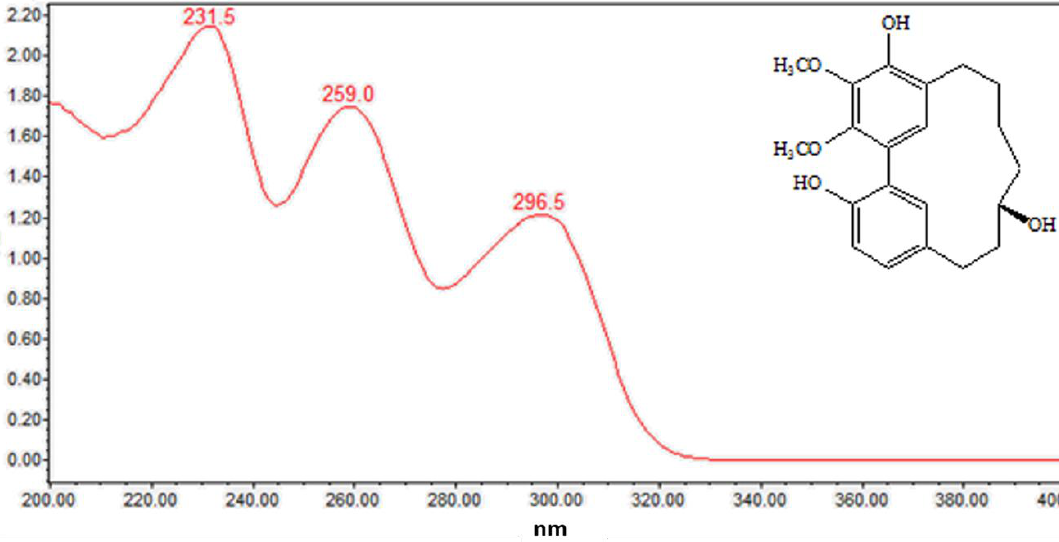
Figure 7. Product ion spectrum and proposed MS fragmentation mechanism of peak 14 in positive mode. 2.1.4. Triterpenoids (Peaks 16 – 19) As can be seen from Figure 8, the triterpenoids mass metabolites could be separated well in 24 – 30 min and, among them, peaks 16 – 19 were identified. According to the literature and chemical standard obtained in our previous phytochemical studies confirmation, peaks 16, 17, 18 and 19 were identified as uosolic acid, myricadoil, uvaol and tarxerol, respectively [11]. The composition of triterpene is complex and structural isomers may exist. Most triterpenoids in the genus Myrica belong to pentacyclic triterpenoids. For further structural analysis, nuclear magnetic resonance spectroscopy is still needed as the ESI-MS spectral data and UV – Vis spectral data were not enough.